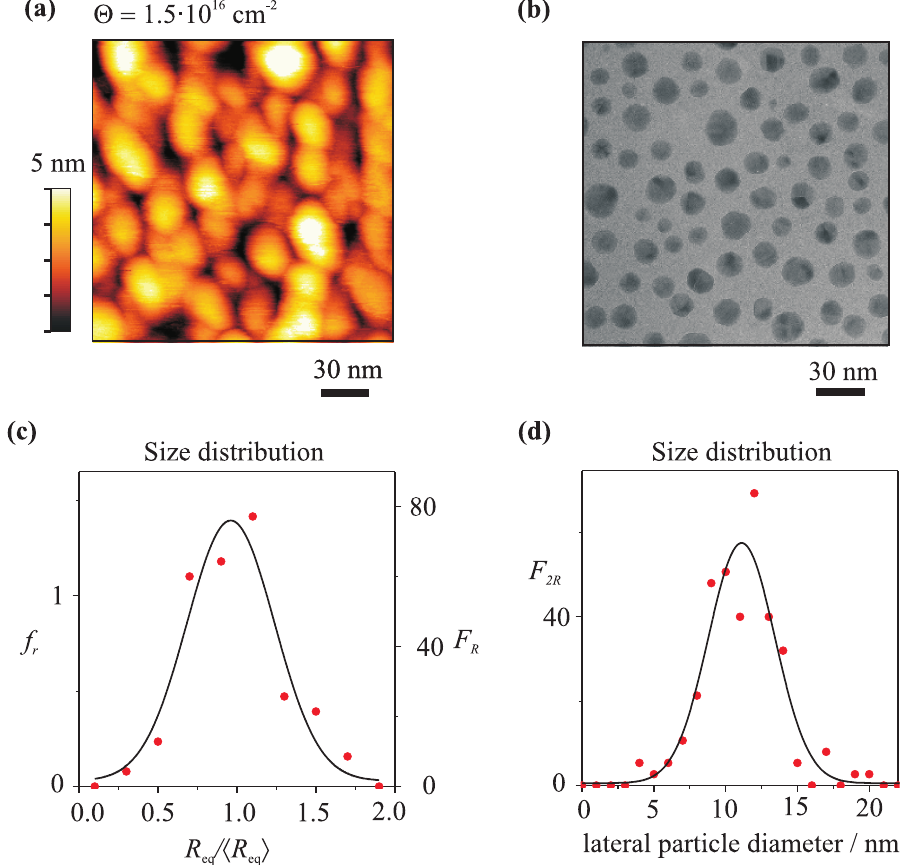
( a ) AFM image of gold particles on a quartz support for a coverage of Θ = (1 . 5 ± 0 . 2) × 10 16 atoms/cm 2 and ( c ) extracted size distribution; ( b ) TEM image of a similar sample and ( d ) extracted size